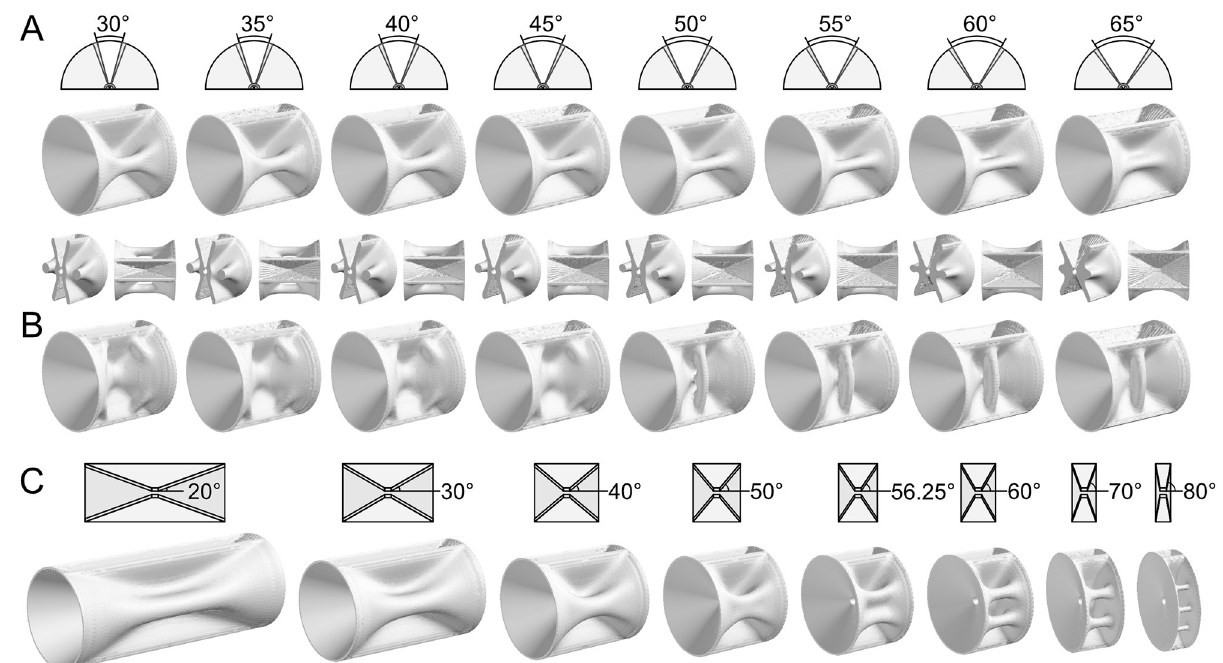
Fig 7. Dependence of lateral structure of vertebral bodies on analysis domain geometry. (A and B) Adjusting the gap width of vertebral arches η . The load case was (A) the bending loads to the autocentrum surface in the horizontal direction and (B) the tensile load to the vertebral arches in the left–right axis direction. The optimization results are displayed every five degrees. In (A), the transverse sections and top views are also displayed. (C) Adjusting the vertebral body lengths in the cranial–caudal direction. The value of θ is displayed. The volume fraction V f is 0.33 in (A), 0.3 in (B), and 0.4 in